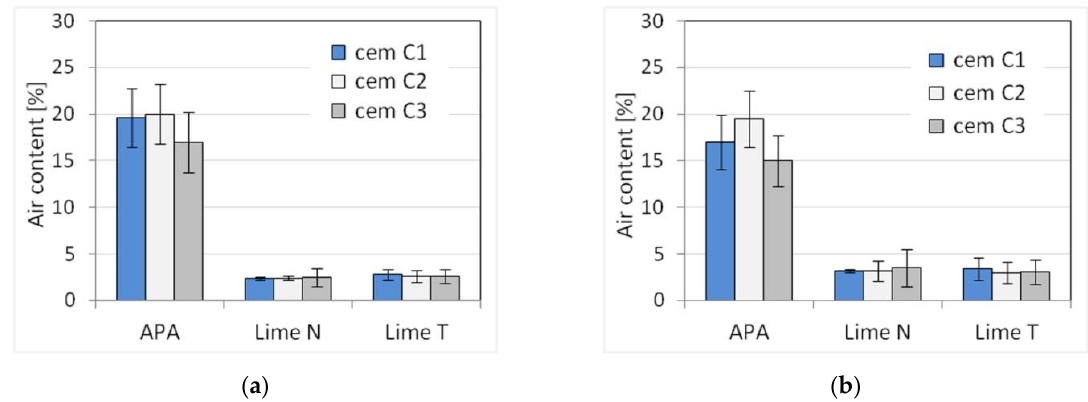
Figure 6. Influence of the cement type on the air content of ( a ) plaster, ( b ) masonry mortars.